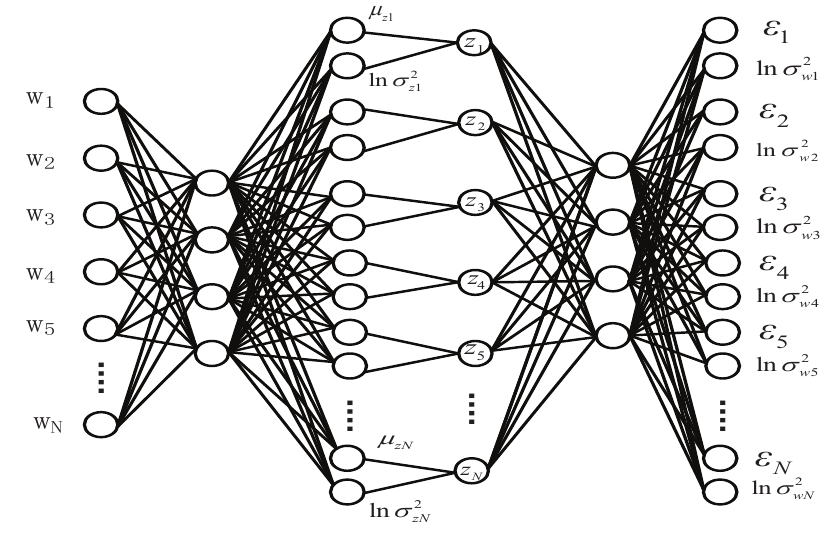
Figure 13. The structure of